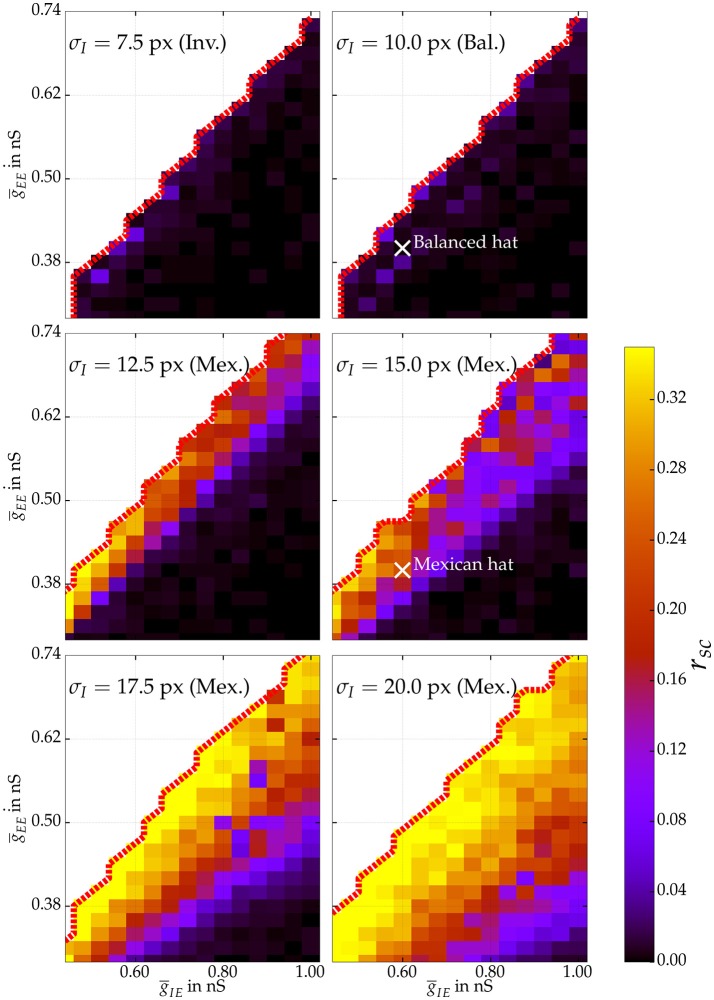
Average noise correlations of cell pairs at most 13.3 px apart in networks with 100 × 100 excitatory neurons. The coefficient is estimated using a sliding window of 1 s over one stimulus presentation of 30 s for various network topologies exploring excitatory synaptic coupling strengths ḡEE and ḡIE. The thick dotted red line marks the bifurcation to self-sustained activity. Excitatory spread σE is fixed to 10 px. Hence, the top row shows correlations for an inverse and balanced spread, whereas below correlations for Mexican hat networks are shown. White crosses mark the parameter settings of balanced and Mexican hat networks that have also been used for estimating information processing quality in Section 4.2.